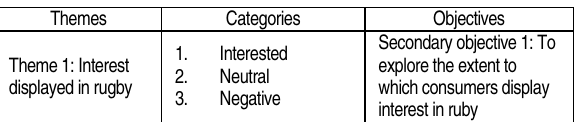
Table 3. Themes and categories generated from